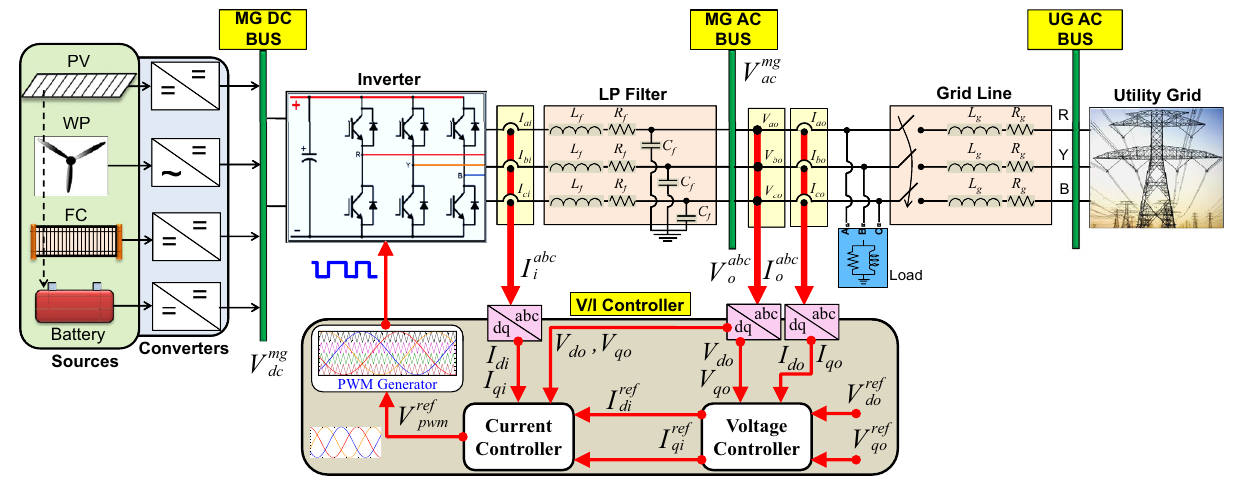
Fig. 1 Representation of the renewable energy sourced microgrid (RESM)